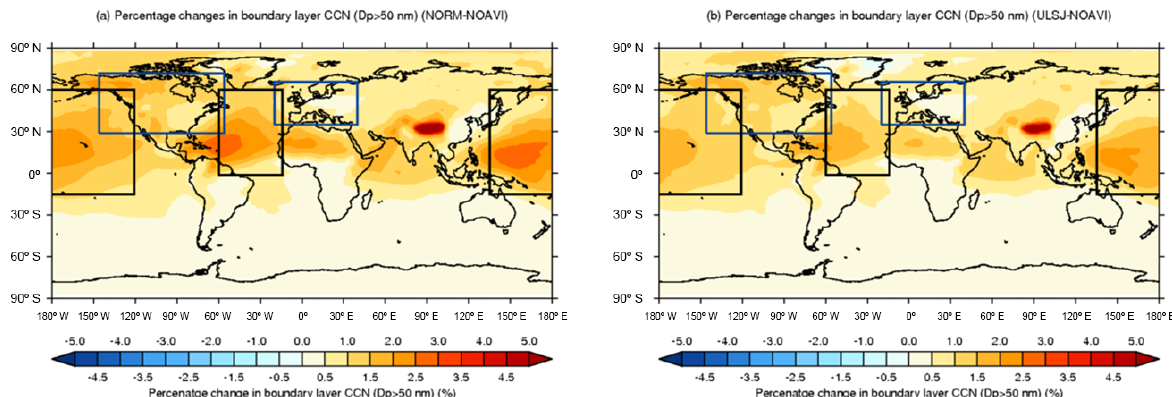
Figure 7. Impact of aviation emissions on low-cloud level (879hPa) CCN ( D p > 50nm) concentrations: (a) standard FSC (NORM–NOAVI) and (b) FSC = 15ppm (ULSJ–NOAVI). Blue boxes define North American and European regions, and black boxes define Atlantic